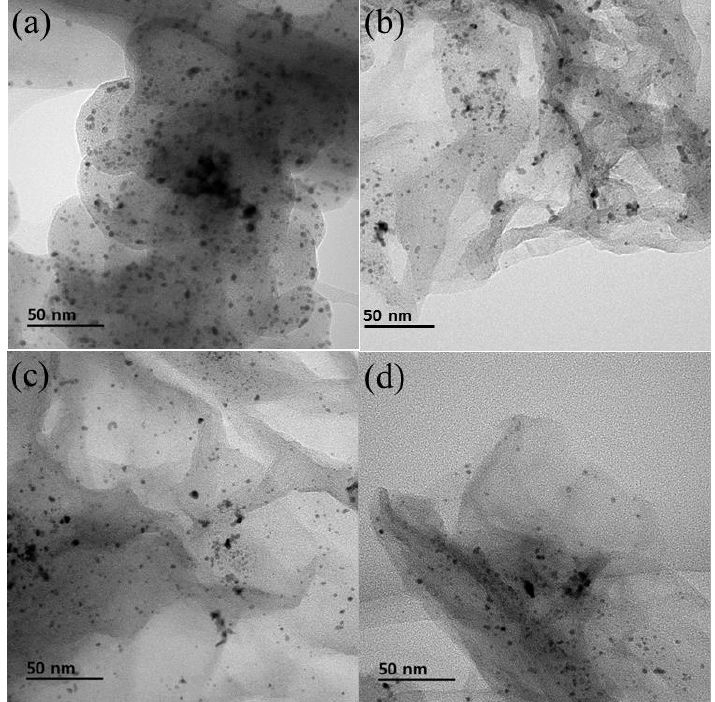
/ C 8 :G 2 ( b ), Pt 6 :G 4 ( c ) and Pt